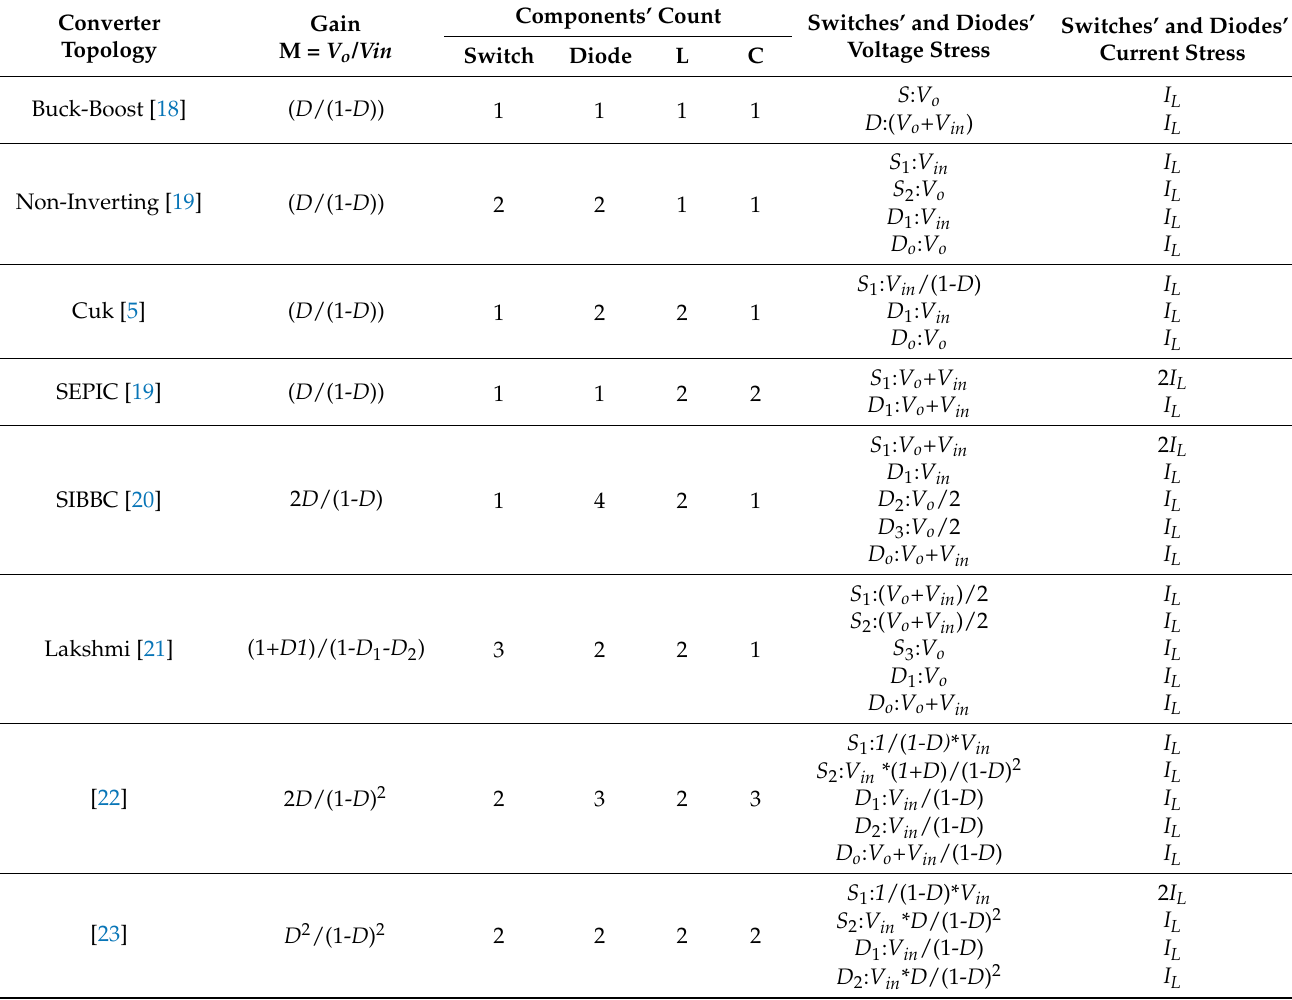
Table 1. Voltage gain and component stress